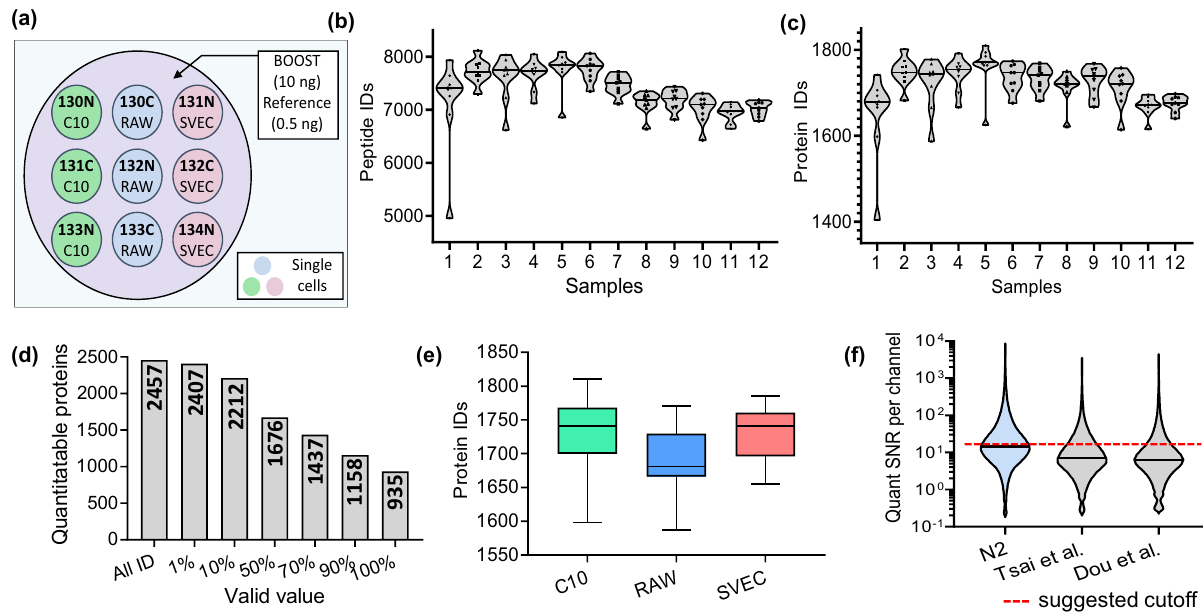
Fig. 3 Single-cell proteomics with N2 chip. a Experiment design showing single-cell isolation and TMT labeling on the N2 chip. b , c The numbers of identi fi ed peptides and proteins in 12 TMT sets. At least one valid value in the nine single-cell channels is required to count as an identi fi cation. Centerlines show the medians; top and bottom horizontal lines indicate the 25th and 75th percentiles, respectively. The data point ( n ) to generate the violin plots is 9. d The numbers of quanti fi able proteins based on different percentages of required valid values. e Box plot showing the distributions of protein identi fi cation numbers ( n = 36 single cells for each cell type). Centerlines show the medians; box limits indicate the 25th and 75th percentiles; whiskers extend 1.5 times the interquartile range from the 25th and 75th percentiles. f Violin plot showing the distributions of signal to noise ratio (SNR) per channel for raw single- cell signals calculated by SCPCompanion 17 . Two published TMT scProteomics datasets from our group using nanowell chip 15,16 were used to benchmark the data generated in this study. Centerlines show the medians; top and bottom horizontal lines indicate the 25th and 75th percentiles, respectively. The numbers ( n ) of SNR datapoints are 284,193 in N2 datasets, 282,190 in Tsai et al. datasets, and 260,039 in Dou et al. datasets. Source data are